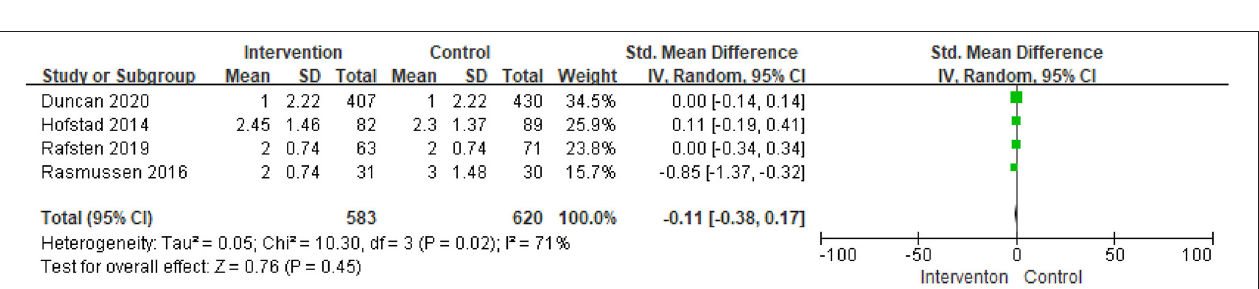
FIGURE 3 | Comparison ESD care vs. usual care; outcome II: activities of daily living (ADL).